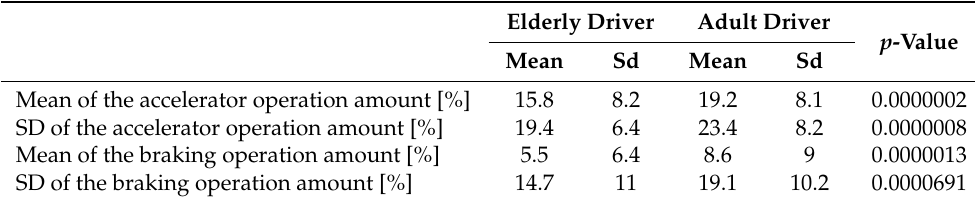
Table 6. The amount of operation of the adult driver and elderly driver groups when the subject drove on the route with a driving simulator.